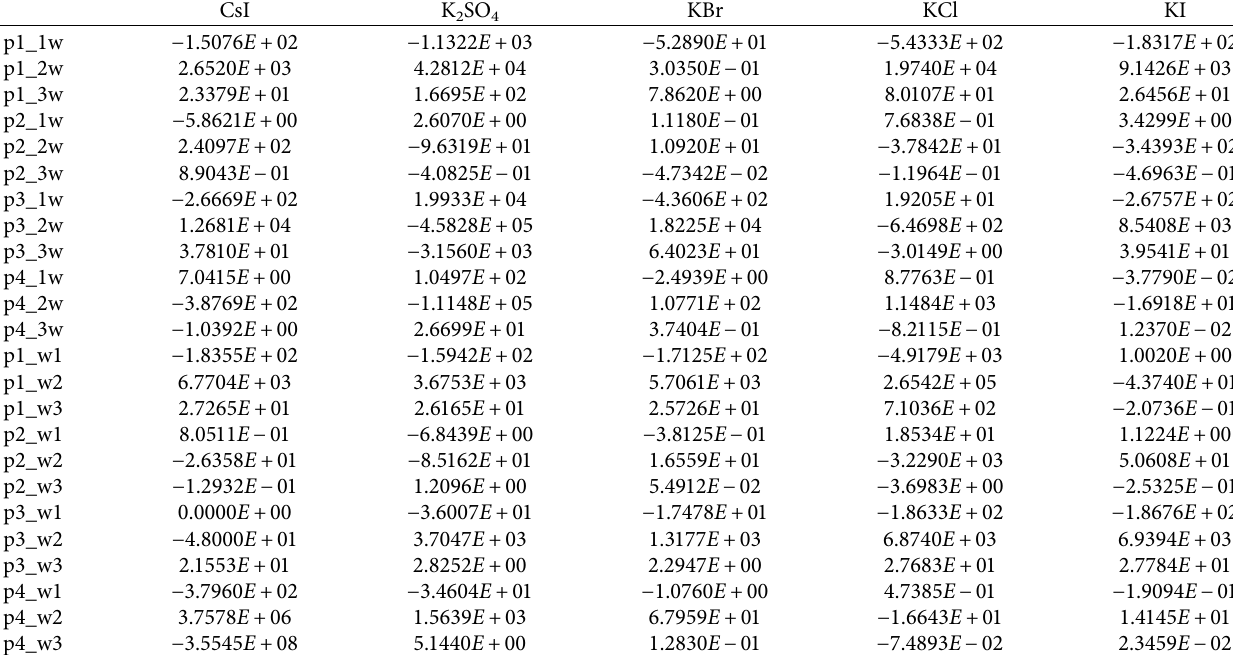
Table 2: Interaction parameters